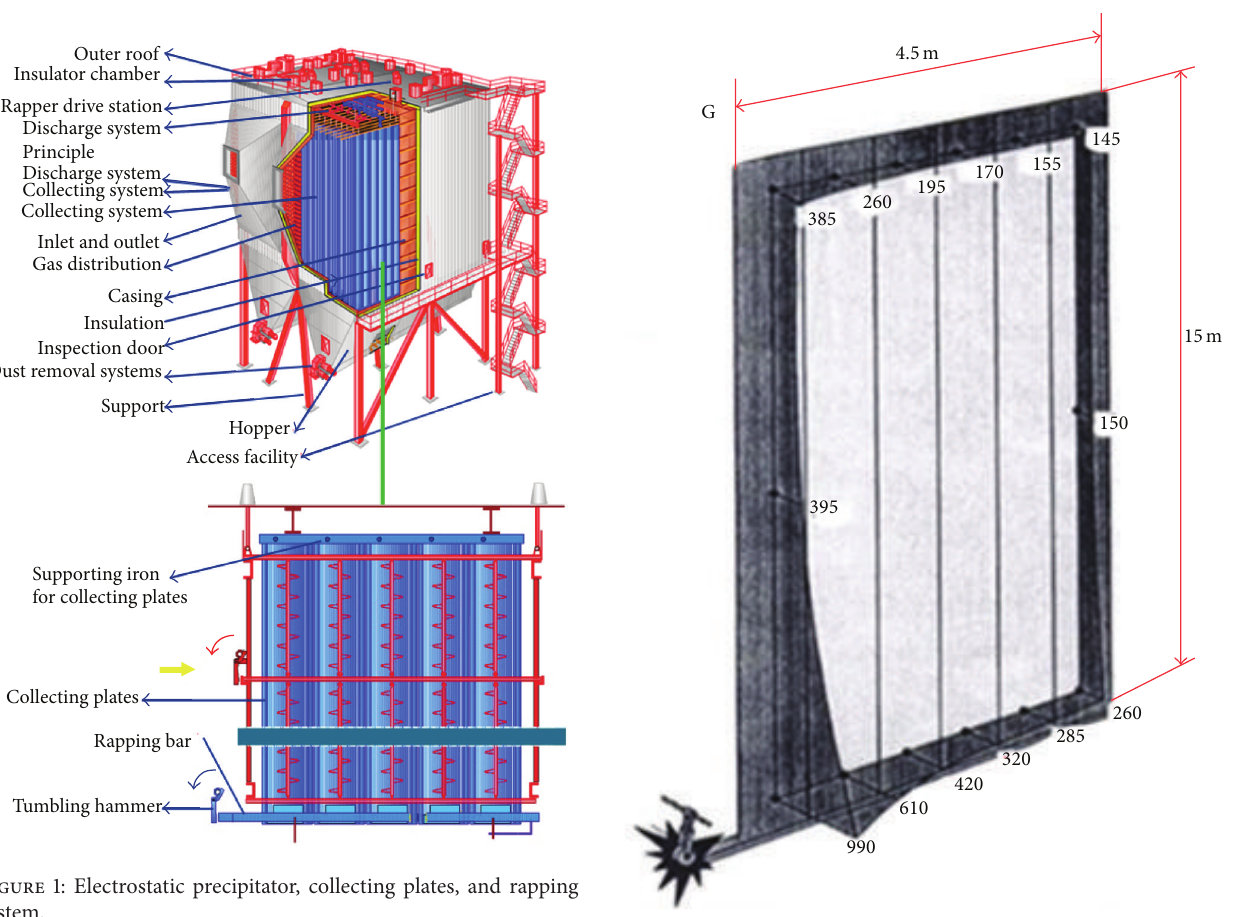
Figure 2: Rapping system of collecting plates and the amount of acceleration in different points of the collecting